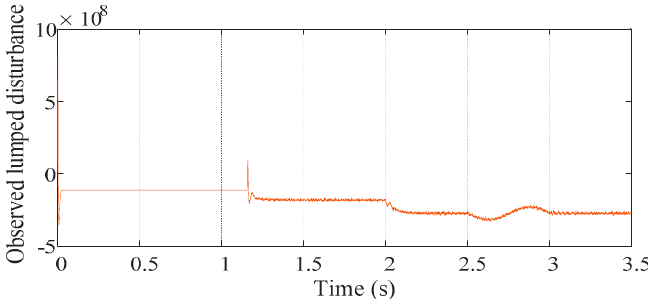
Figure 28. The lumped disturbance observed by LESO.